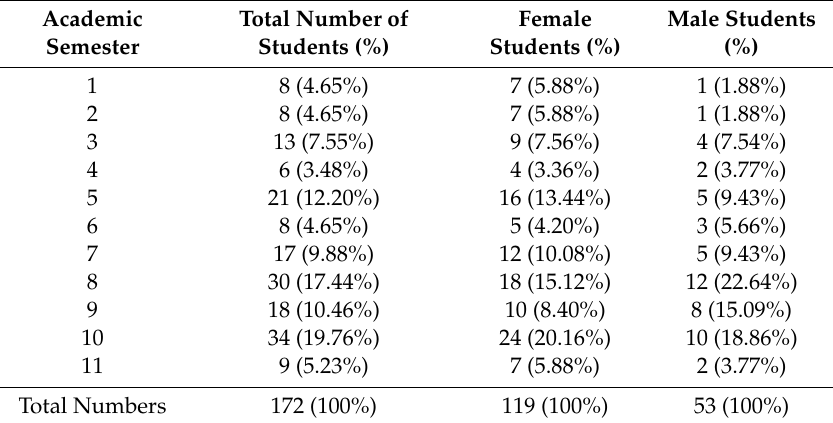
Table 2. Distribution of participating students by academic semester and